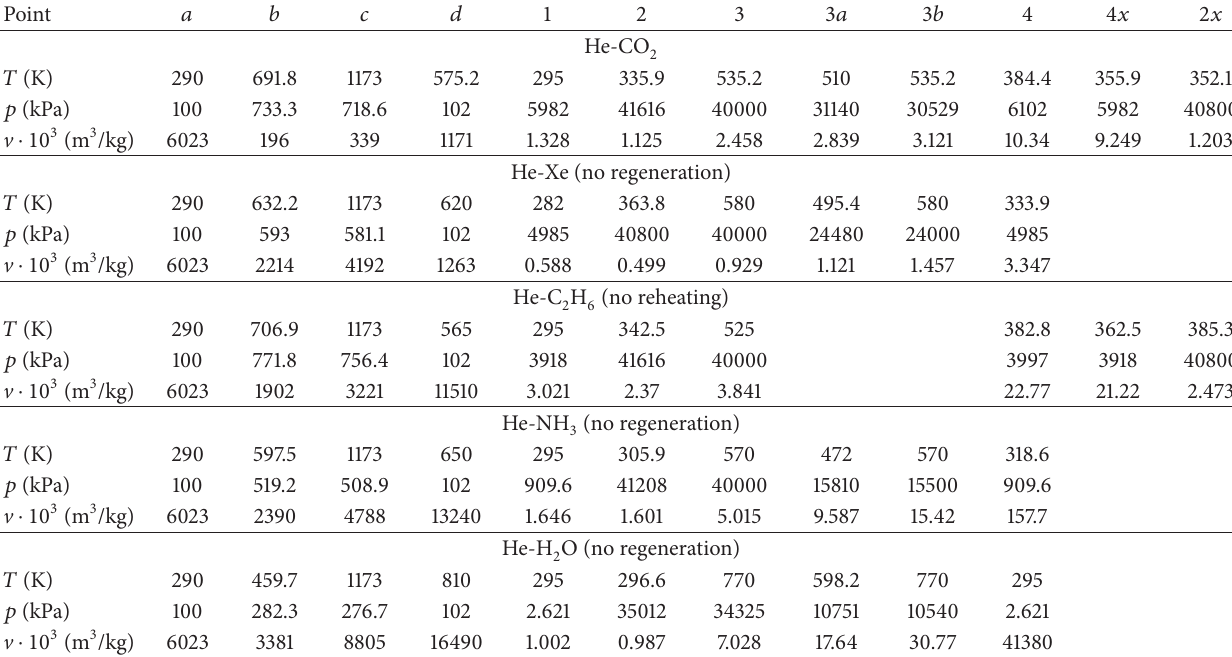
Table 7: The CC state points for the CBC with helium as WF and carbon dioxide, xenon, ethane, ammonia and water as WF for the RC.